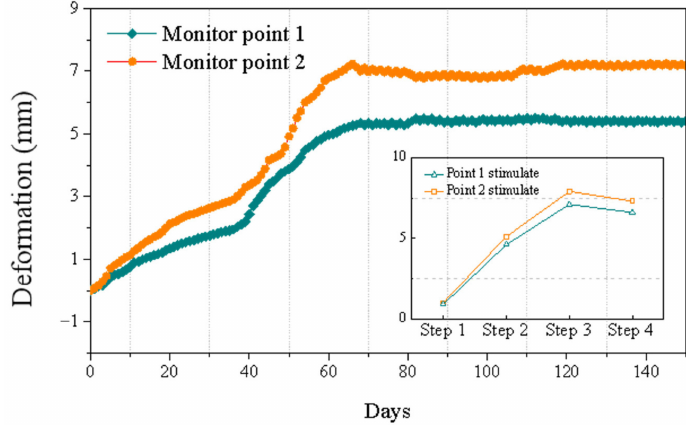
Figure 6. Horizontal displacement on top of the diaphragm